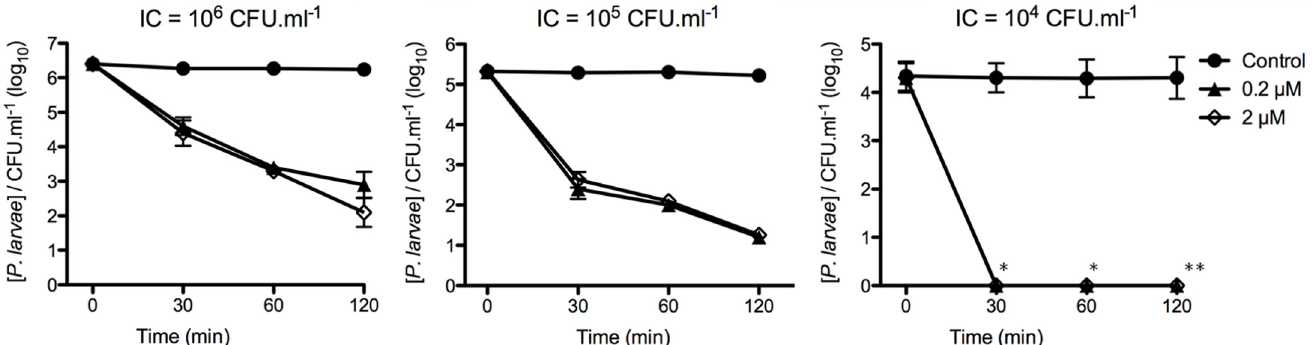
Fig 3. PlyPl23 activity on different P . larvae concentrations. PlyPl23 activity on P . larvae Pl02-23, at different enzyme (0.2 μ m and 2.0 μ m) and bacteria concentrations (10 6 , 10 5 and 10 4 CFU.mL -1 ). * Detection limit of 100 CFU.mL -1 ; ** Detection limit of 10 CFU.mL -1